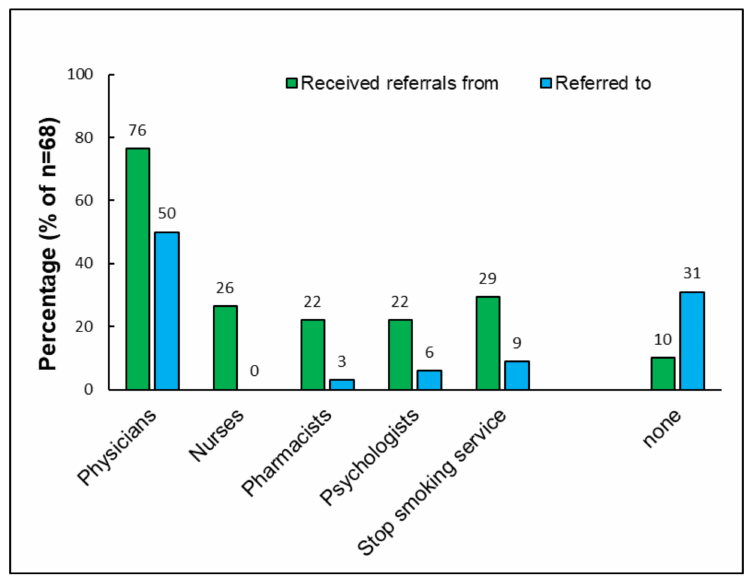
Figure 1. Percentage of respondents who say that health care professionals refer customers and who say they refer customers to health care professionals.